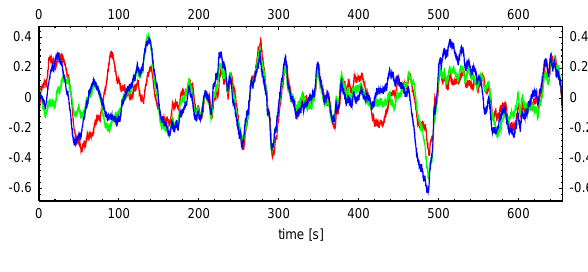
Fig. 3. Detrended GPS phase for three receivers: red – 05, green – 06, blue – 16.